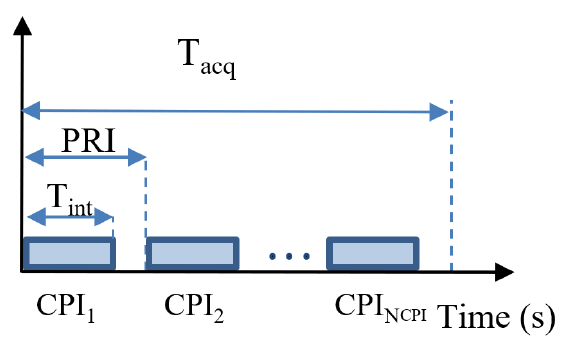
Figure 2. Time parameters for PR data